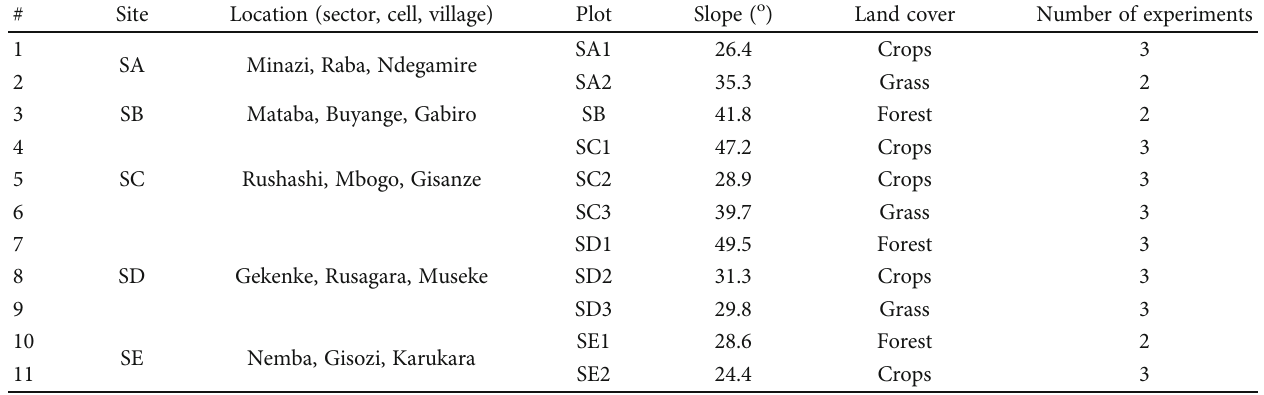
Table 2: Geotopographical characteristics of representative sites in the study